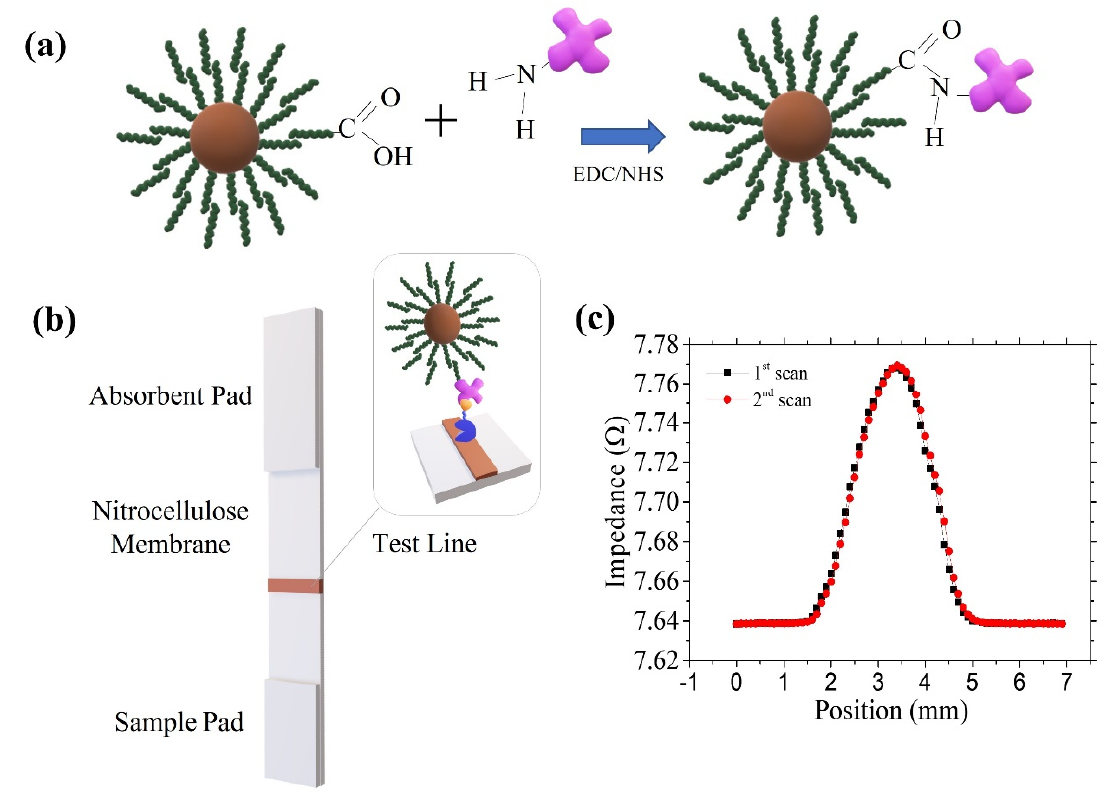
Figure 1. ( a ) Scheme of the particles’ biofunctionalization process with neutravidin by the EDC/NHS chemistry. For simplification, only one functional group has been represented on the surface of the MNPs and the neutravidin. ( b ) Schematic view of a lateral flow strip and its test line: a neutravidin- MNP complex captured by a molecule of biotin. ( c ) Impedance variation for two scans of the OA@NP sample.